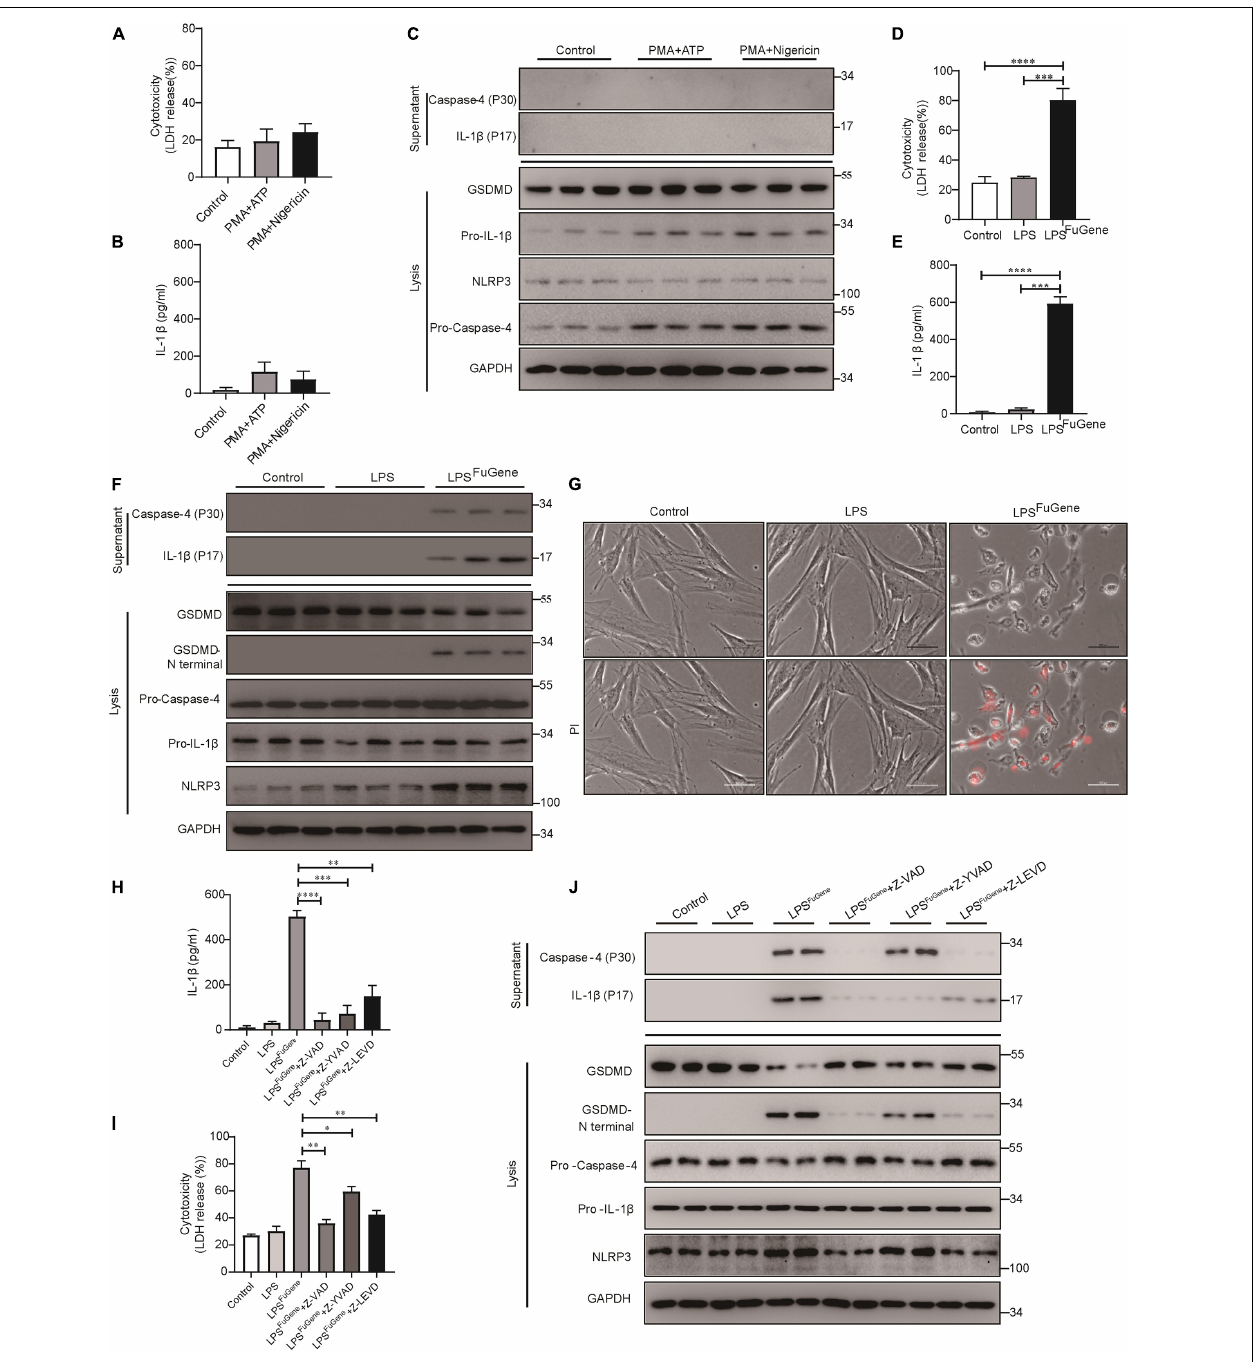
FIGURE 3 | PDLSC pyroptosis was mediated by the caspase-4-dependent non-canonical pyroptosis pathway. (A–C) PDLSCs were pretreated with PMA for 1 h and stimulated with ATP or nigericin for 4 h. (A,B) Cell culture supernatant was collected and assayed for LDH release (A) and IL-1 β secretion (B) . (C) The IL-1 β and Caspase-4 secreted into the culture supernatants and the GSDMD cleavage, Pro-IL-1 β , Pro-Caspase-4, NLRP3, and GAPDH in the cell lysates (lysis) were detected by immunoblotting. (D–G) PDLSCs were treated with LPS or transfected with LPS using FuGene HD for 16 h. Cells without treatment were used as controls. (D,E) Cell culture supernatant was collected and assayed for LDH release (D) and IL-1 β secretion (E) . (F) The IL-1 β and Caspase-4 secreted into the culture supernatants and the GSDMD cleavage, Pro-IL-1 β , Pro-Caspase-4, NLRP3, and GAPDH in the cell lysates (lysis) were detected by immunoblotting. (G) Representative images of propidium iodide (PI, red) uptake. (H–J) PDLSCs were pretreated with the pan-caspase inhibitor Z-VAD-FMK (20 µ M), the caspase-1 inhibitor Z-YVAD-FMK (20 µ M), or the capase-4 inhibitor Z-LEVD-FMK (20 µ M) for 1 h before transfection with LPS (LPS FuGene ) for 16 h. (H) IL-1 β ELISA in supernatants. (I) Percentage of LDH release in supernatants. (J) The IL-1 β and Caspase-4 secreted into the culture supernatants and the GSDMD cleavage, Pro-IL-1 β , Pro-Caspase-4, NLRP3, and GAPDH in the cell lysates (lysis) were detected by immunoblotting. The data are presented as the mean ± SEM. * P < 0.05, ** P < 0.01, *** P < 0.001, **** P < 0.0001.